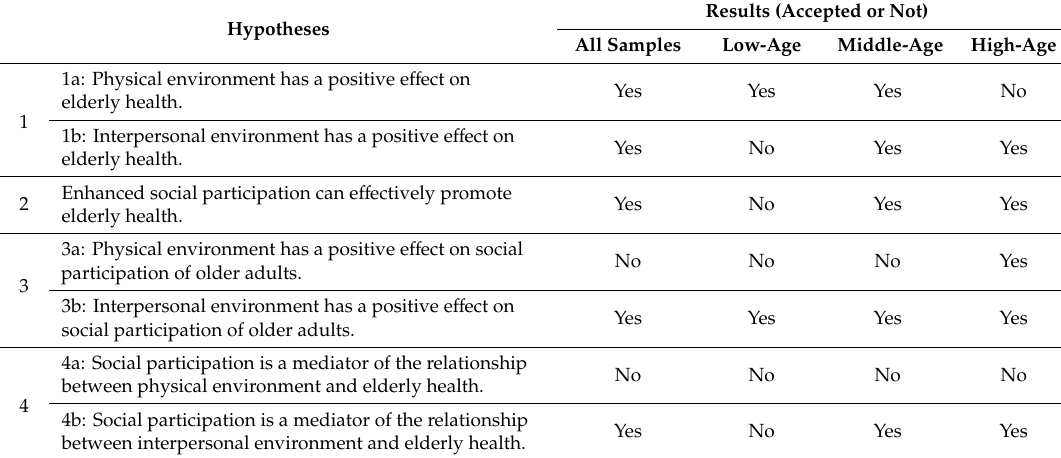
Table 5. Test results of